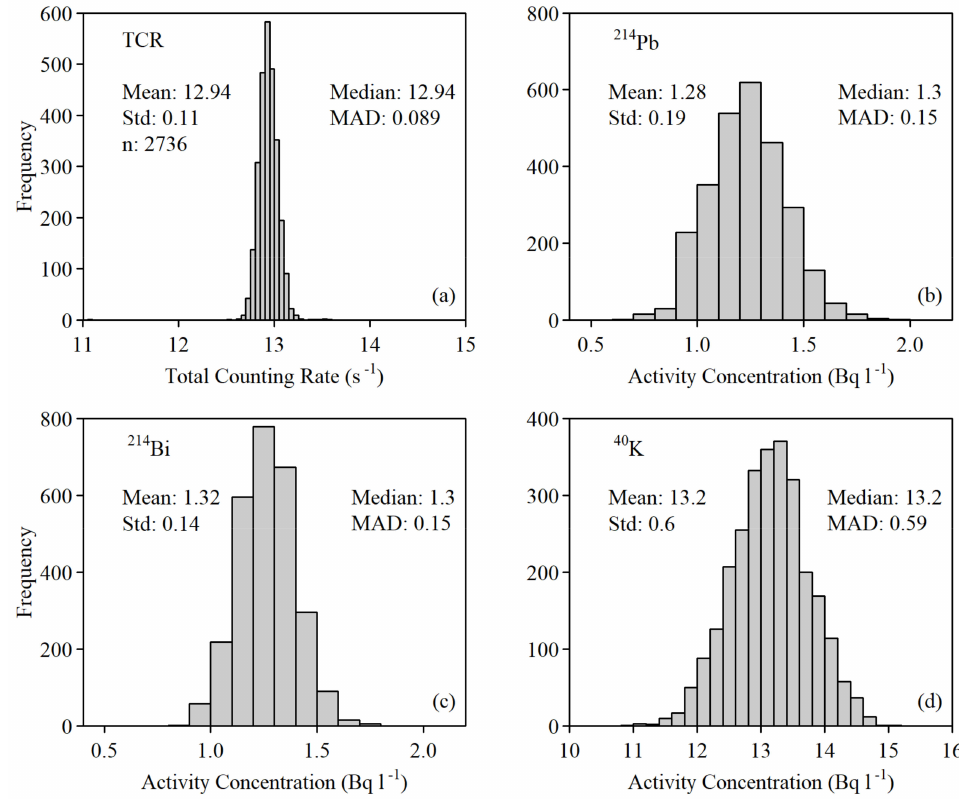
Figure 2. Descriptive analysis of TCR ( a ), radon progenies 214 Pb ( b ), 214 Bi ( c ) and 40 K ( d ) activity concentration values during dry meteorological